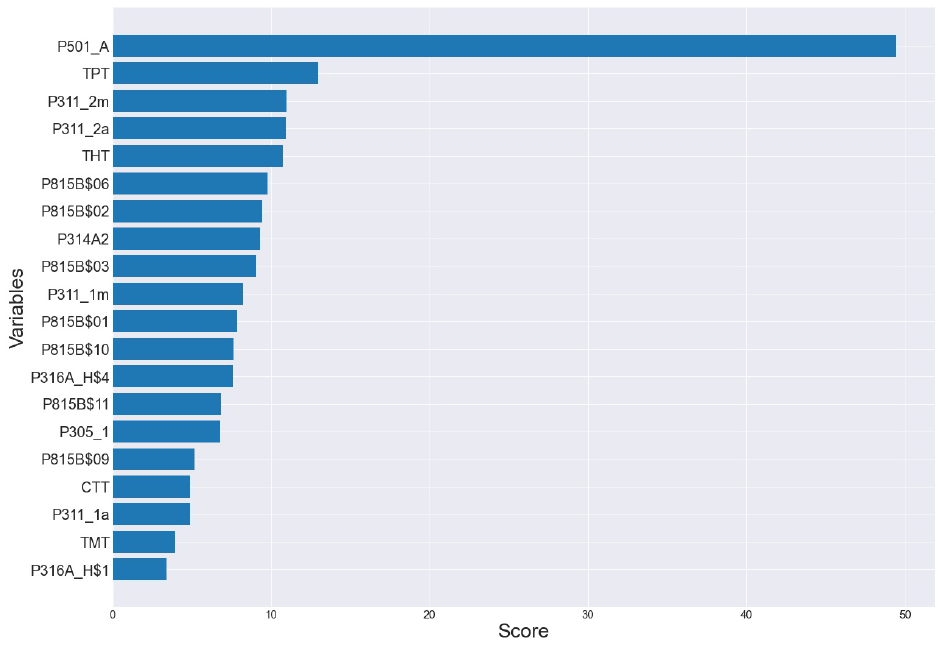
Figure 2. ANOVA scores in predicting teacher job